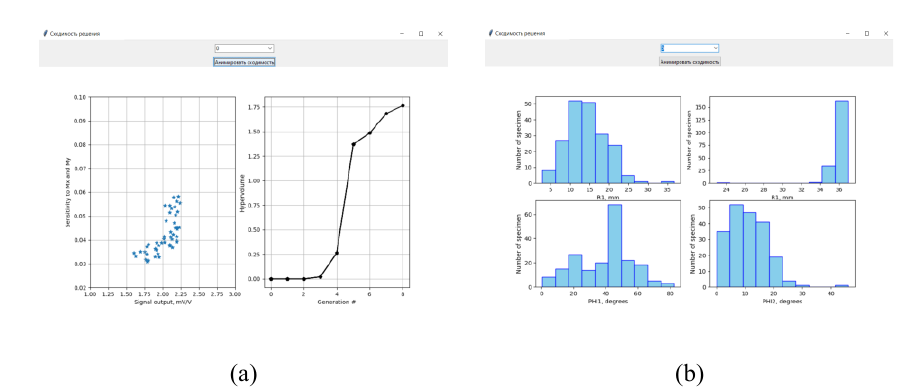
Fig. 8 . User interface of the module for investigating the population evolution in the objective (a) and design (b) spaces, results for a given generation can be chosen using a combo box.